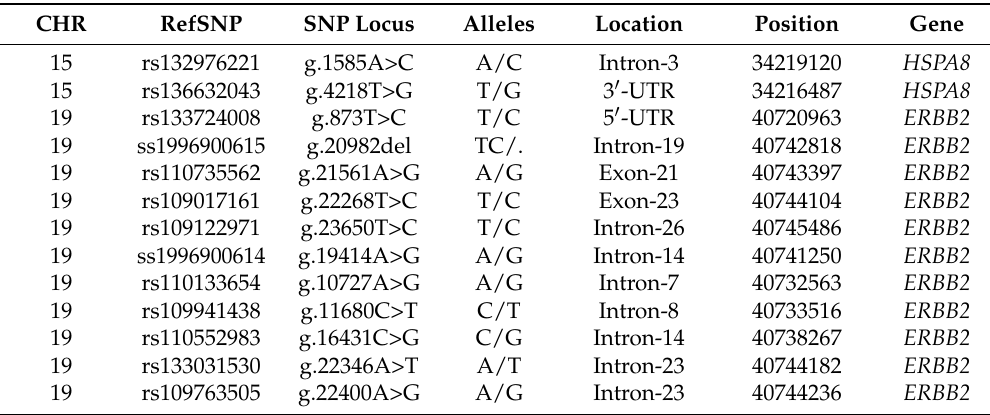
Table 1. Information for the identified single-nucleotide polymorphisms (SNPs) in HSPA8 and ERBB2